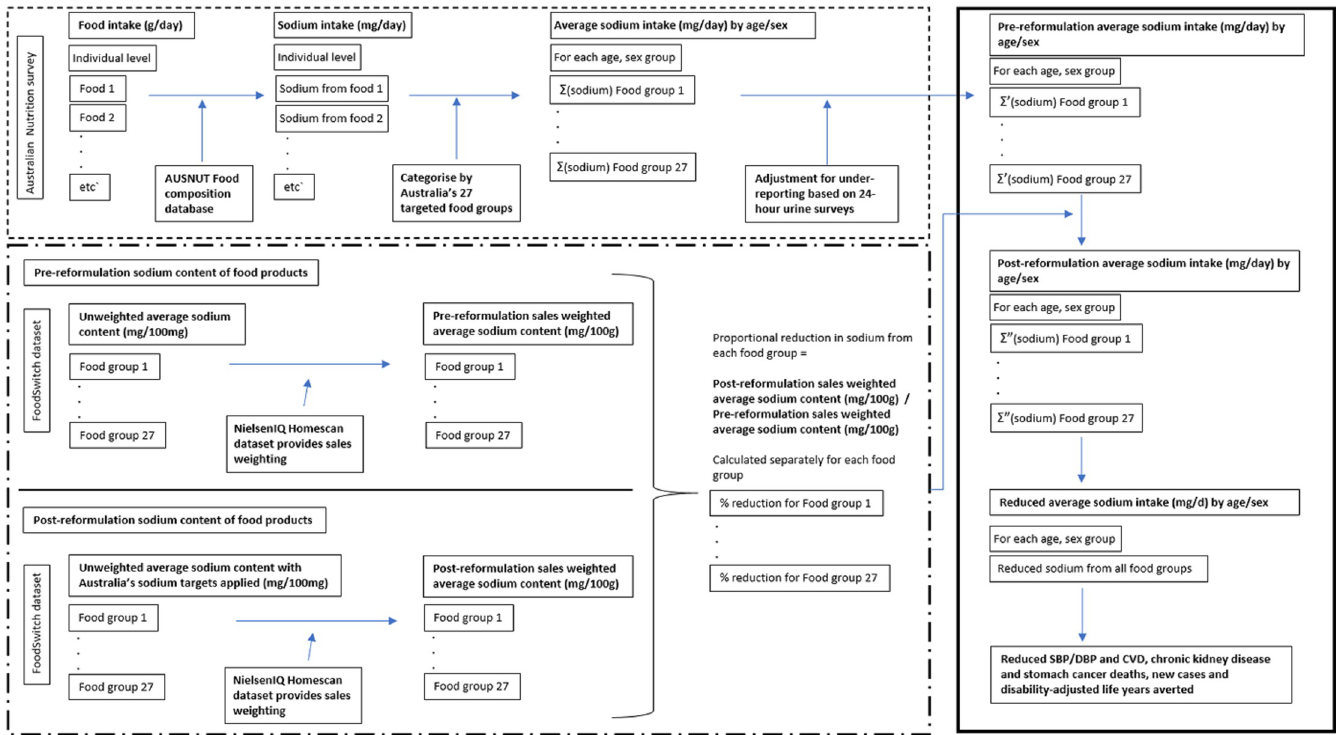
Fig 1. Conceptual model used to estimate the pre-reformulation sodium intake for specific food groups for Australian adults, the post-reformulation sodium intake for specific food groups if companies comply with the Australian government’s 2020 sodium reformulation program (and more stringent programs using the same methods), and the subsequent health benefits of reduced sodium intake for 24 age–sex groups. In the first part of the model (shown in the dashed box), using an Australian nationally representative dietary survey, individual-level food intake data (g/d) at the most specific food level was obtained and matched with the Australian (AUSNUT) food composition database to calculate sodium from each food. Each food and their equivalent sodium contribution were then categorized into the 27 Australian sodium reformulation food groups or 76 UK food groups with sodium targets, and the average sodium intake (mg/d) from all food groups were calculated for each of the 24 age–sex groups. Given that 24-hour diet recalls underestimate food and sodium intake, sodium intake calculated from the diet recall was adjusted up to the daily sodium intake from nondiscretionary sources estimated based on 24-hour urinary sodium excretion for Australian men and women separately. This resulted in the pre-reformulation average sodium overall and for each food group (mg/d) for each age–sex group. To calculate the reduction in sodium intake from each food group as a result of full compliance to the Australian or UK targets, as shown in the dash-dot box, we calculated the pre-reformulation sales-weighted average sodium content of targeted food groups by weighting the sodium content of food products within their food group by their volume of sales (kg). Similarly, the post- reformulation sales-weighted average sodium content was calculated by simulating reductions in the sodium content of foods that were above the target to the targeted level (products with sodium content below the target remained the same). The proportional reduction in sodium from each food group was calculated by dividing the post-reformulation with the pre-reformulation sales-weighted average sodium contents. Finally, we multiplied the pre-reformulation sodium intake from each food group by the proportional reduction in sodium from each food group to obtain the post-reformulation sodium intake from the specific food category (shown in the solid box). The reductions between the pre- and post-reformulation sodium intake for each food group were summed to determine the total average sodium intake reduced for each age–sex group. Using the absolute reduction in average sodium intake for each age–sex group, we estimated the reduction in blood pressure and CVD, CKD, and stomach cancer deaths and new cases averted. S represents the sum of multiple items. CKD, chronic kidney disease; CVD, cardiovascular disease; DBP, diastolic blood pressure; SBP, systolic blood